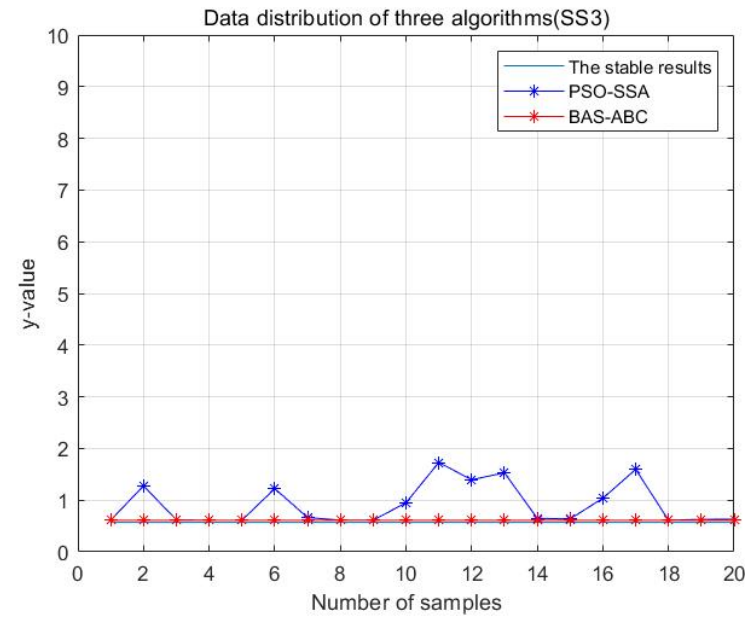
Figure 29. Data distribution—20 of two hybrid algorithms (SS3). Figure 30. Data distribution—20 of two hybrid algorithms (CSR1).